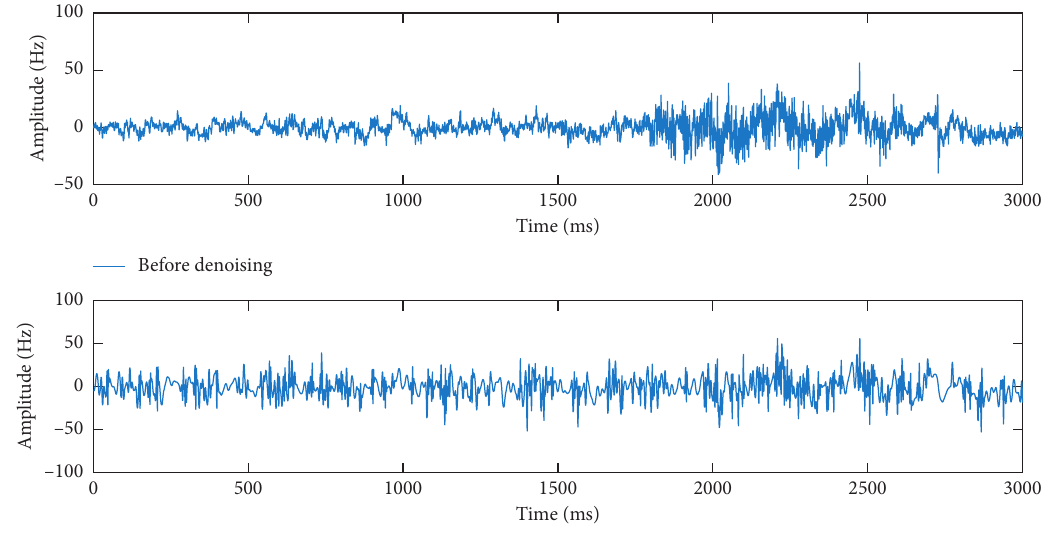
Figure 7: Before and after denoising on data to reduce noise interference.